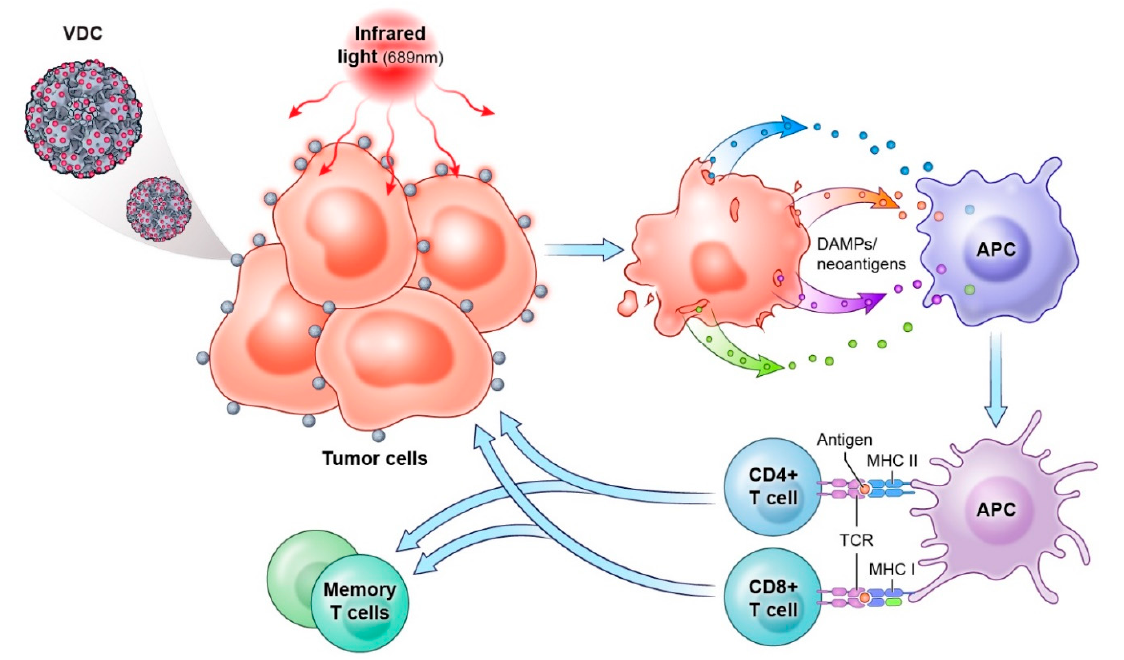
Figure 3. Mechanism of AU-011 (belzupacap sarotalocan) mediated tumor killing. AU-011 binds to the surface of tumor cells and is activated by near infrared light. The killed tumor cells release DAMPs and neoantigens into the local tumor milieu resulting in uptake by and activation of antigen presenting cells. Both CD4+ and CD8+ T cells are activated and are necessary for localized tumor control and long-term protection from tumor re-challenge. Virus-like drug conjugate (VDC); damage associated molecular patterns (DAMPs); antigen presenting cells (APC); major histocompatibility complex (MHC); T cell receptor (TCR).